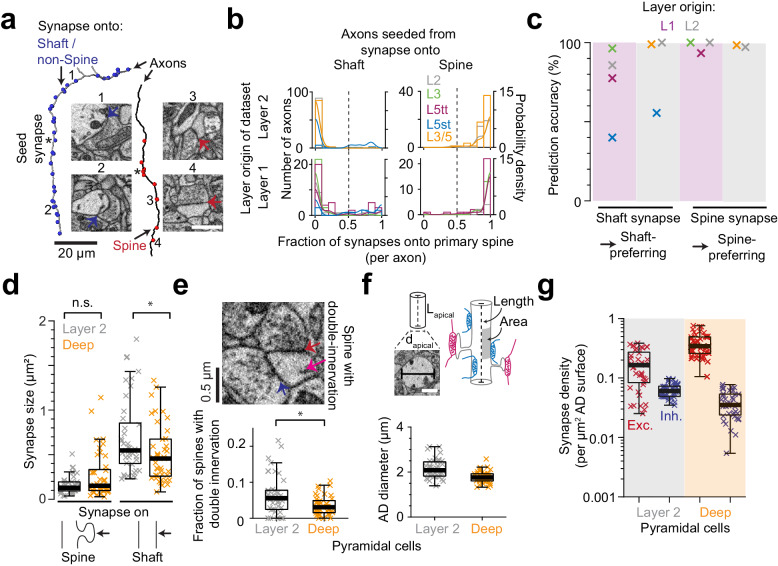
Effect of synapse identity, size, dendrite diameter and double-innervated spines on synaptic composition of apical dendrites.(a) Reconstruction of two axons seeded from synapses onto ADs (asterisks) and all the output synapses within the volume (red: spine, blue: shaft/non-spine). Note the stark difference in their innervation preference based on their seed location. Example spine (red arrows, 3: https://wklink.org/5224, 4: https://wklink.org/9411) and shaft (blue arrows, 1: https://wklink.org/8807, 2: https://wklink.org/3270) synapse EM micrographs (insets). (b) Histogram for the fraction of synapses made onto single-innervated spines. Axons seeded from synapses on deep (orange), L2 (gray), L3 (green), L5tt (magenta) and L5st (blue) ADs. Annotations are from layer 1 (n = 142, LPtA dataset) and layer 2 (n = 288, S1, V2, PPC and ACC datasets); probability density estimations and synapse identity threshold as solid and dashed lines, respectively. Note highly bimodal distribution allowing the clear distinction of axons into spine-preferring (excitatory) and shaft-preferring (putative inhibitory), with exception of axons innervating shafts of L5st ADs (these were corrected in the following, see c). (c) Scatter plot for accuracy in predicting presynaptic axon type (shaft- vs. spine-prefering) based on the location of synapse on AD (shaft vs. spine). (d) Size of synapses onto deep (n = 41, orange crosses) and layer 2 (n = 41, gray crosses) ADs. (e) Fraction of double-innervated spines in the main bifurcation annotations of deep (orange, n = 41) and layer 2 (gray, n = 41) neurons. Spine with putative inhibitory (blue arrow) and excitatory (red arrow) inputs (inset). (f) Sketches illustrating the synapse density normalized to surface area and length of AD and their measurement (upper panel). Box plot of the average diameter of layer 2 (gray, n = 41) and deep (orange, n = 41) AD around the main bifurcation in S1, V2, PPC and ACC datasets (lower panel, p < 10−4, Wilcoxon rank-sum test). (g) Box plot of putative inhibitory (blue crosses) and excitatory (red crosses) synapse densities per µm2 of AD surface area for L2 (n = 41, left) and DL ADs (n = 41, right). Wilcoxon rank-sum test, p < 10−6 for both densities. Asterisks indicate significance level of the Wilcoxon rank-sum test (not significant (n.s.): p > 0.05,*p < 0.05). Scale bars: 1 µm (inset in a,f).Figure 2—source data 1.Dendritic spine vs. shaft innervation preference for AD-targeting axons (Figure 2b).Figure 2—source data 2.Prediction accuracy for dendritic shaft vs. spine innervation preference (Figure 2c).Figure 2—source data 3.Size of synapses onto ADs (Figure 2d).Figure 2—source data 4.Fraction of dendritic spines with double-innervation (Figure 2e).Figure 2—source data 5.Apical dendrite diameter and the synapse density normalized to surface area of ADs (Figure 2f, g).